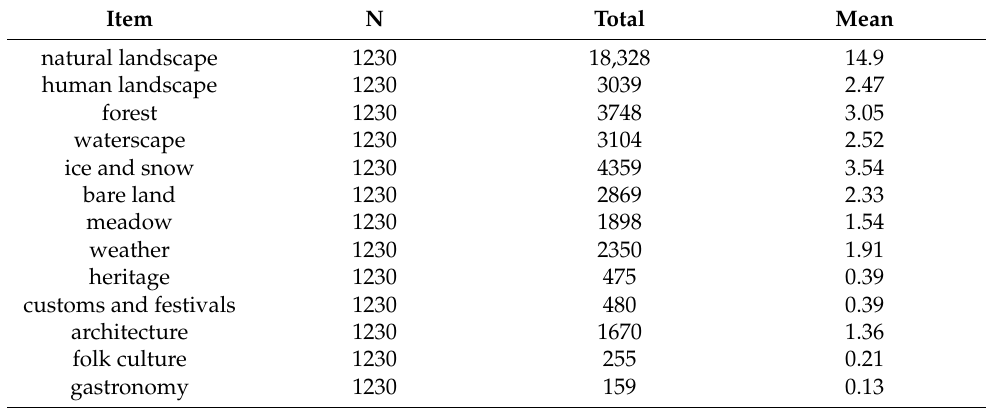
Table 2. Profile of landscape types